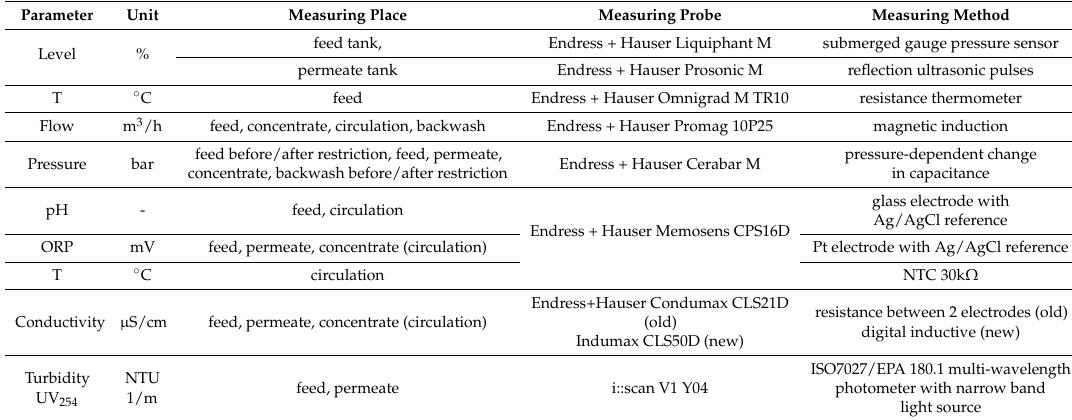
organic carbon. Table A2. Online measuring probes for operational and water quality parameter; unit, measuring place, measuring probe, measuring method.